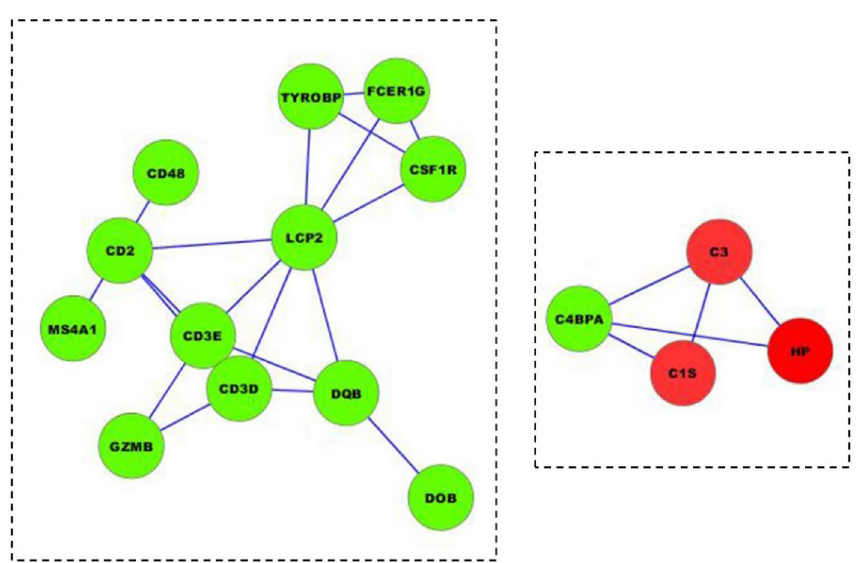
Figure 10. The protein–protein interaction networks of the significantly differentially expressed genes associated with the immune system. The sketch represents the interaction network constructed for protein- coding DEGs. Green nodes indicate down-regulated genes, and red nodes indicate up-regulated genes. The lines indicate the interactions between the gene